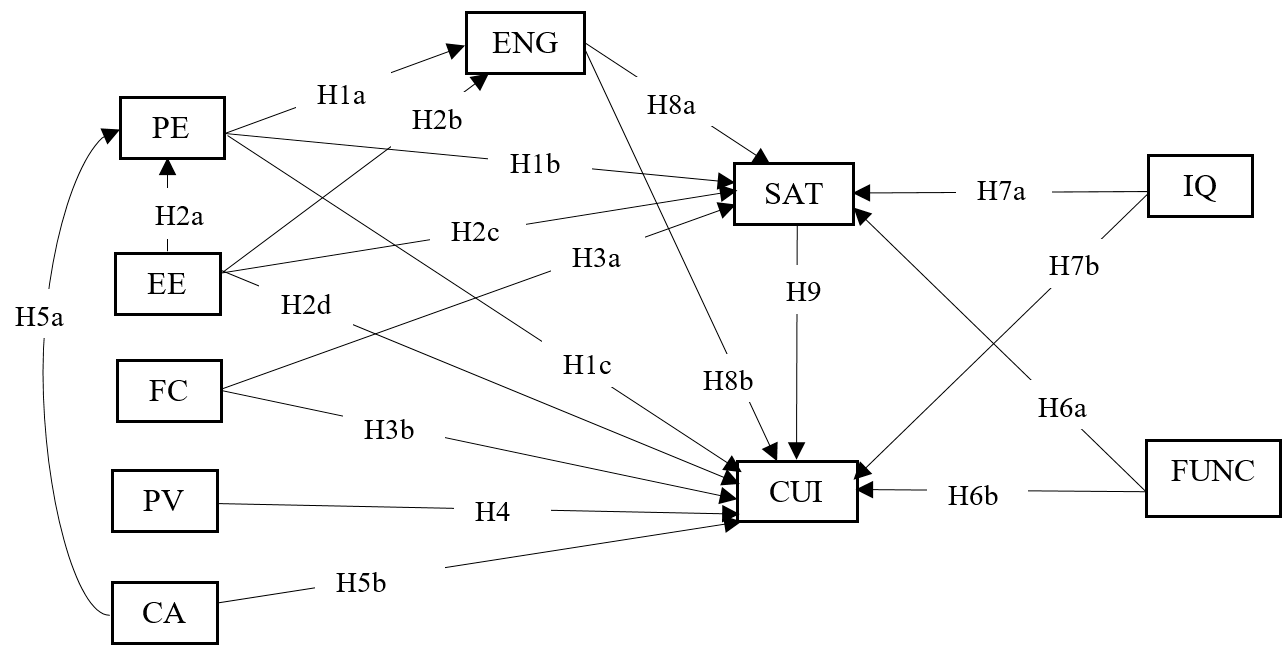
Figure 1. Hypothesized research model. Mediating paths: PE → ENG → CUI ( H10a ), EE → ENG → CUI ( H10b ), PE → SAT → CUI ( H11a ), EE → SAT → CUI ( H11b ), and FC → SAT → CUI ( H11c ). Notes: performance expectancy = PE, effort expectancy = EE, facilitating condition = FC, price value = PV, contamination avoidance = CA, engagement = ENG, functionality = FUNC, information quality = IQ, satisfaction = SAT, and continuous usage intention = CUI. Table 1. Summary of the latest research on the context of telemedicine services in both developed and developing economies.